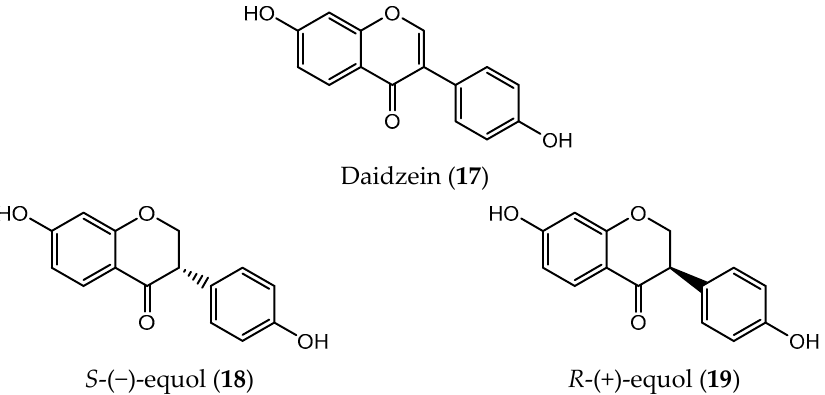
Figure 5. Chemical structure of daidzein ( 17 ) and its metabolites ( 18 and 19 ). Flavoalkaloids are relatively rare natural products with a flavonoid framework con- taining nitrogen fragments attached on position 6 and/or 8 of the A-ring (Figure 6) [102]. In nature, these compounds are found mostly in plants, but also in animals and bacteria [102,103].